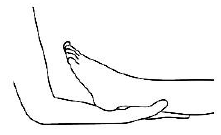
Figure 3. Ankle support, eighth bilateral touch.